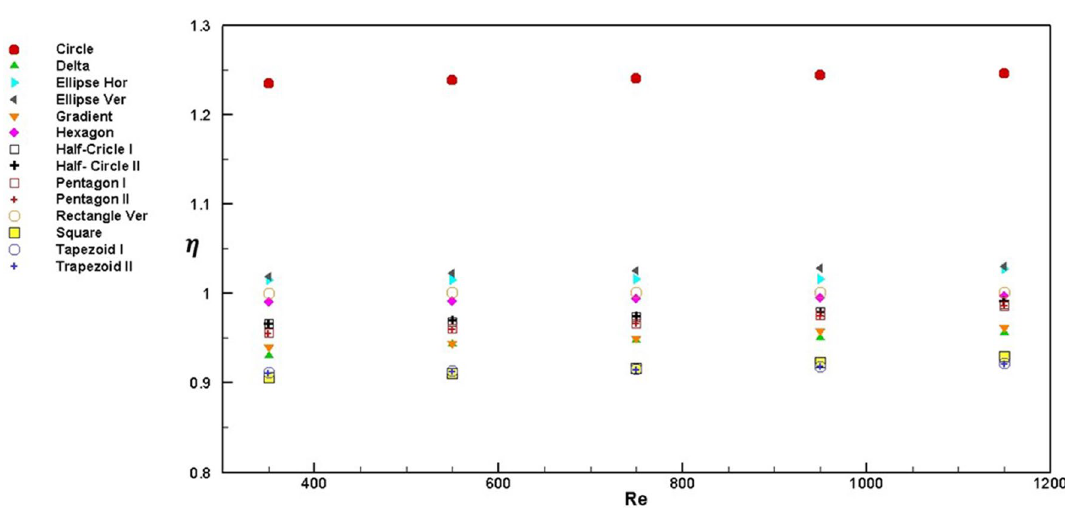
Figure 8. Performance evaluation criteria index of different cross-sections at different Reynolds